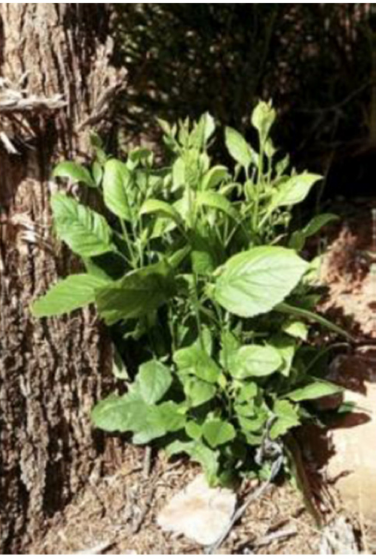
Figure 4. Witches’ brooms at the root collar of an ash yellows-affected velvet ash ( Fraxinus velutina ) tree (courtesy W.A. Sinclair, Department of Plant Pathology, Cornell University, Ithaca, NY,